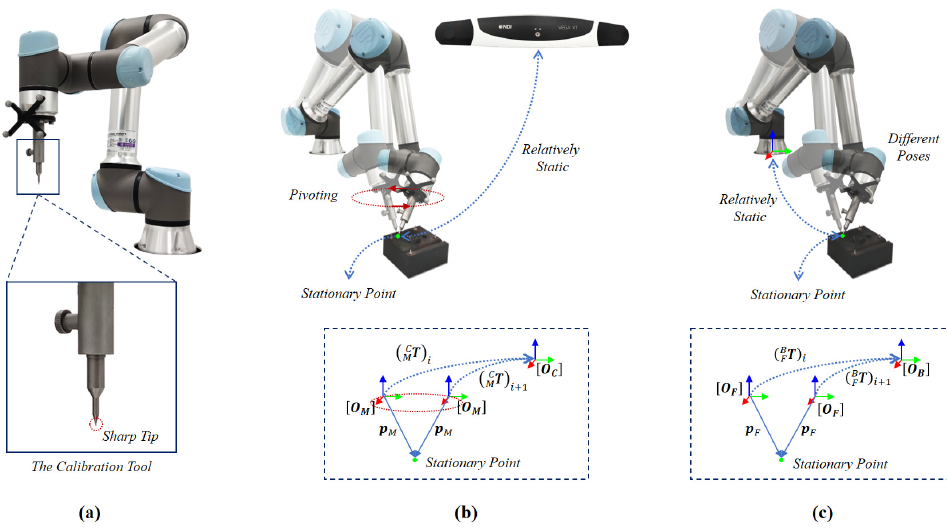
Figure 2. Tool-tip pivot calibration. ( a ) The calibration tool with a sharp tip is rigidly fixed to the flange during the hand–eye calibration; ( b ) pivot calibration of the offset of the tool tip with respect to the 3D COS O M of the optical reference frame on the end-effector; ( c ) pivot calibration of the offset of the tool tip with respect to the robotic flange COS O F